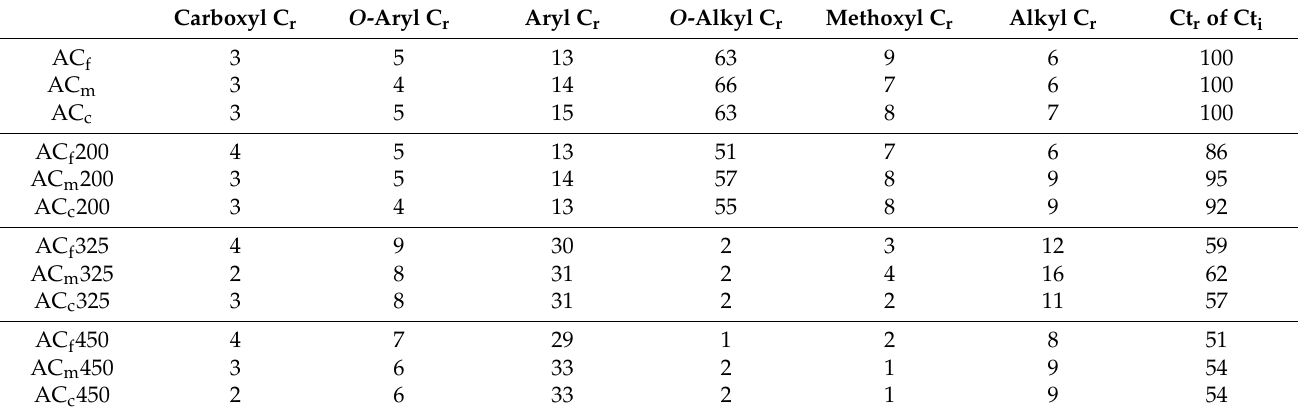
Table 4. Remaining total C (C tr ) and remaining C (C r ) of each C group of the initial total C (C ti in % of C ti ) of the Acrocomia endocarp after pyrolysis at different